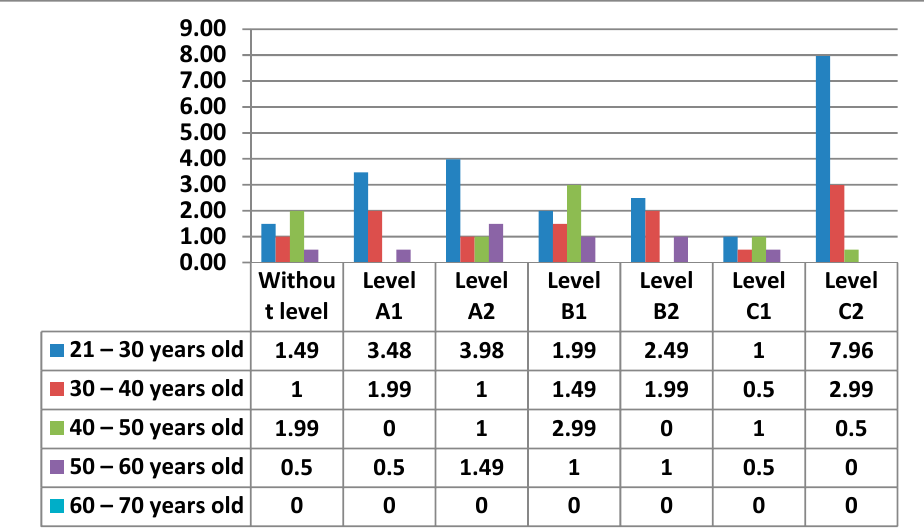
Figure 24. Digital competence in women by age in Area 4.